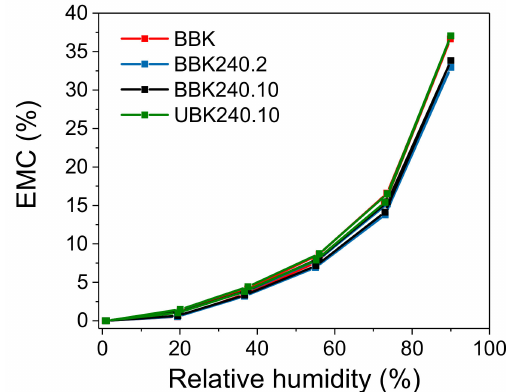
Figure 5. Equilibrium moisture content (EMC) of CNF films as a function of RH in the atmosphere. Sample names are the same as in Figures